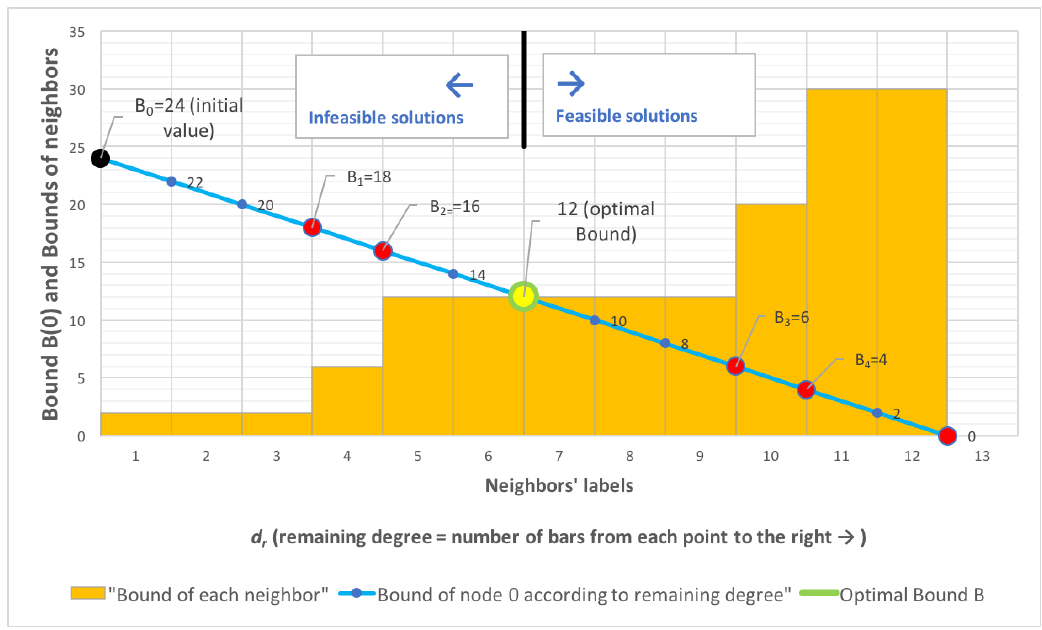
Figure 4. Graphical execution of the function bound() described in Algorithm 2 for the node 0 in Figure